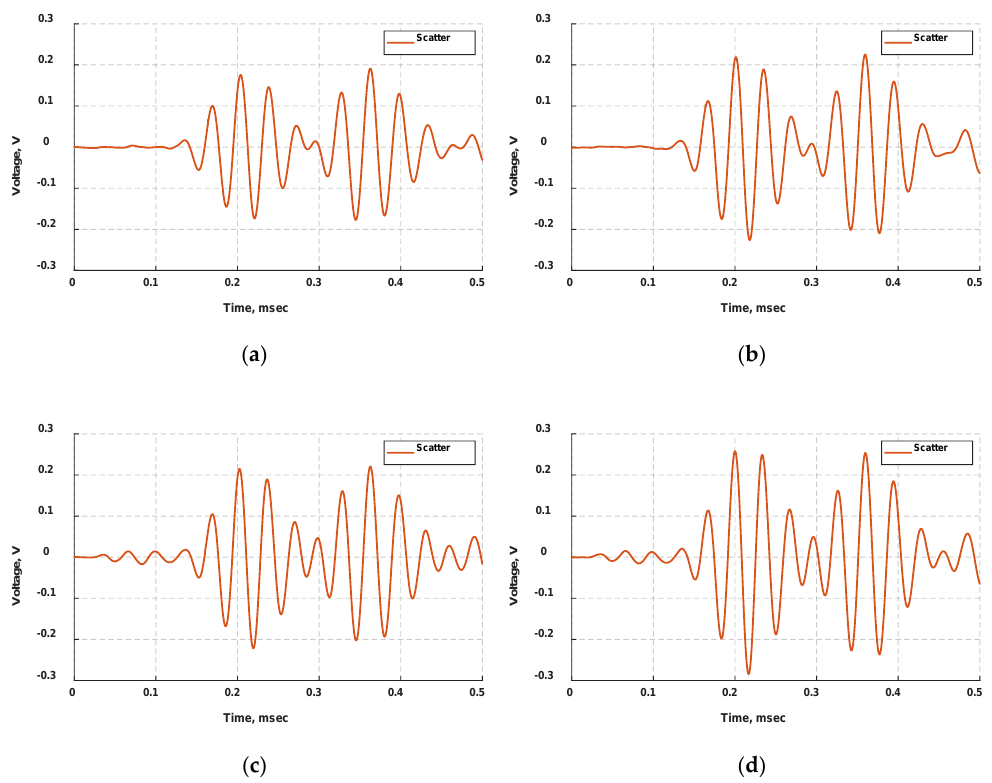
Figure 14. Scattered signals from laminate specimen at no-preload condition (left column) and 50 N mid-span preload (right column) at 1.3 mm three-point loading cycle: ( a , b ) d15 PZT-2 sensor and ( c , d ) d31 PZT-3 sensor.